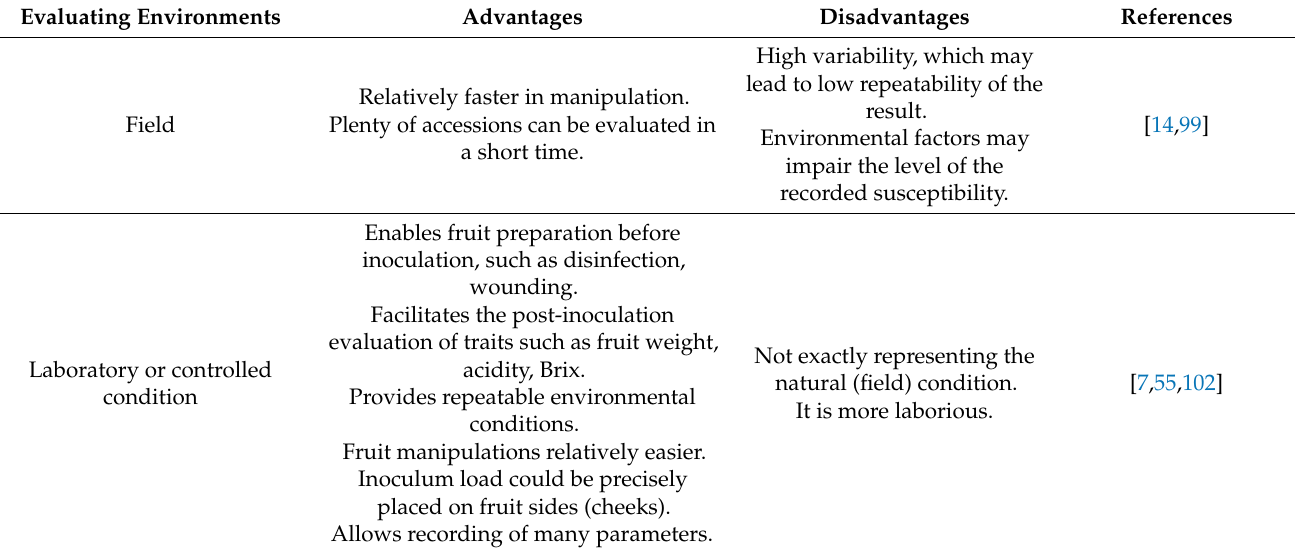
Table 2. Advantages and disadvantages of field and laboratory-based protocols to evaluate fruit resistance level. Evaluating Environments Advantages Disadvantages